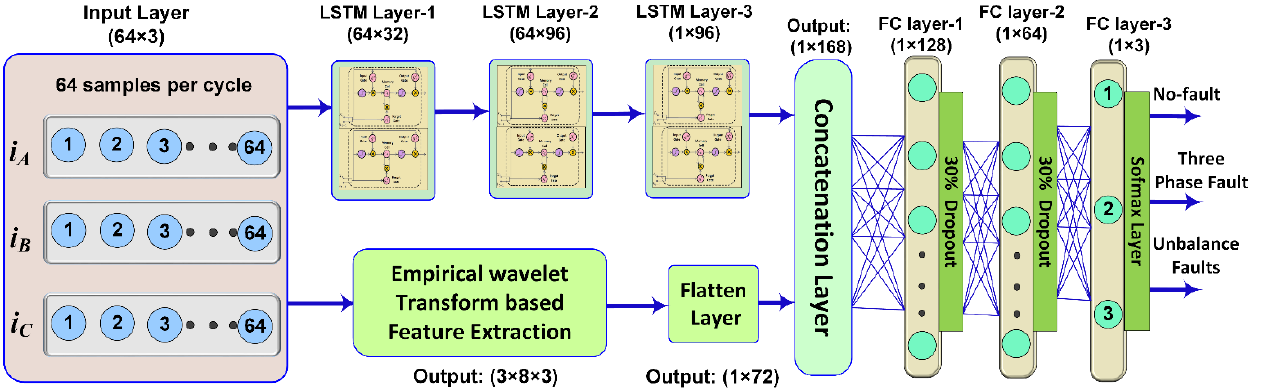
Figure 5. Schematic diagram of fault type detection unit.